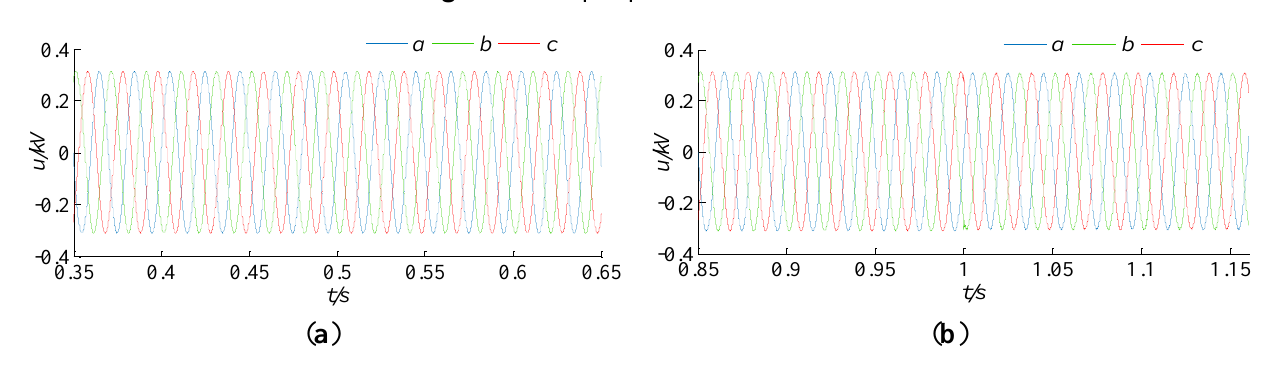
Figure 9. Output power of the MSC.